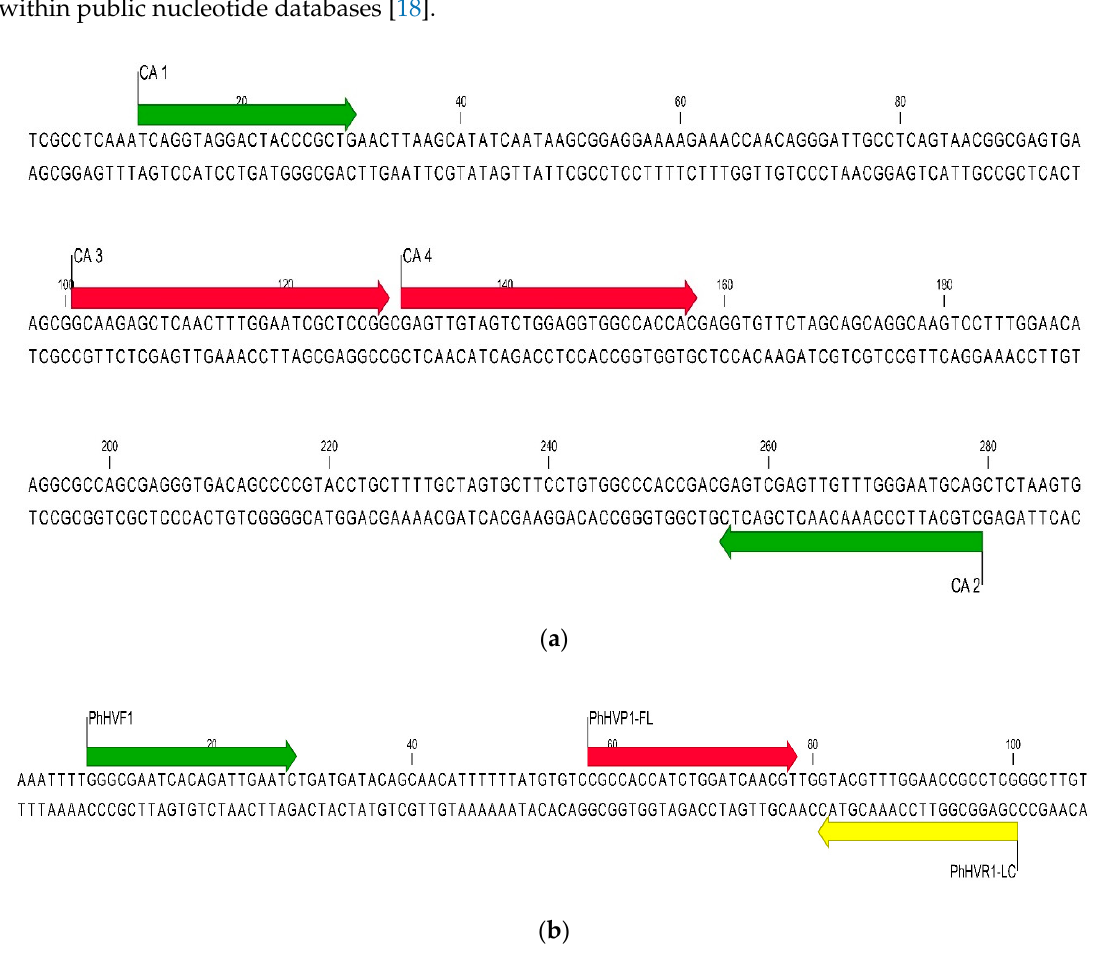
Figure 1. ( a ) Sequence alignment of the C. auris internal transcribed spacer (ITS) target region with the PCR assay primers (green arrows) and probes (red arrows). ( b ) Sequence alignment of the Phocine herpesvirus type 1 internal control target region with the PCR assay primers (green and yellow arrows) and probes (red and yellow arrows).